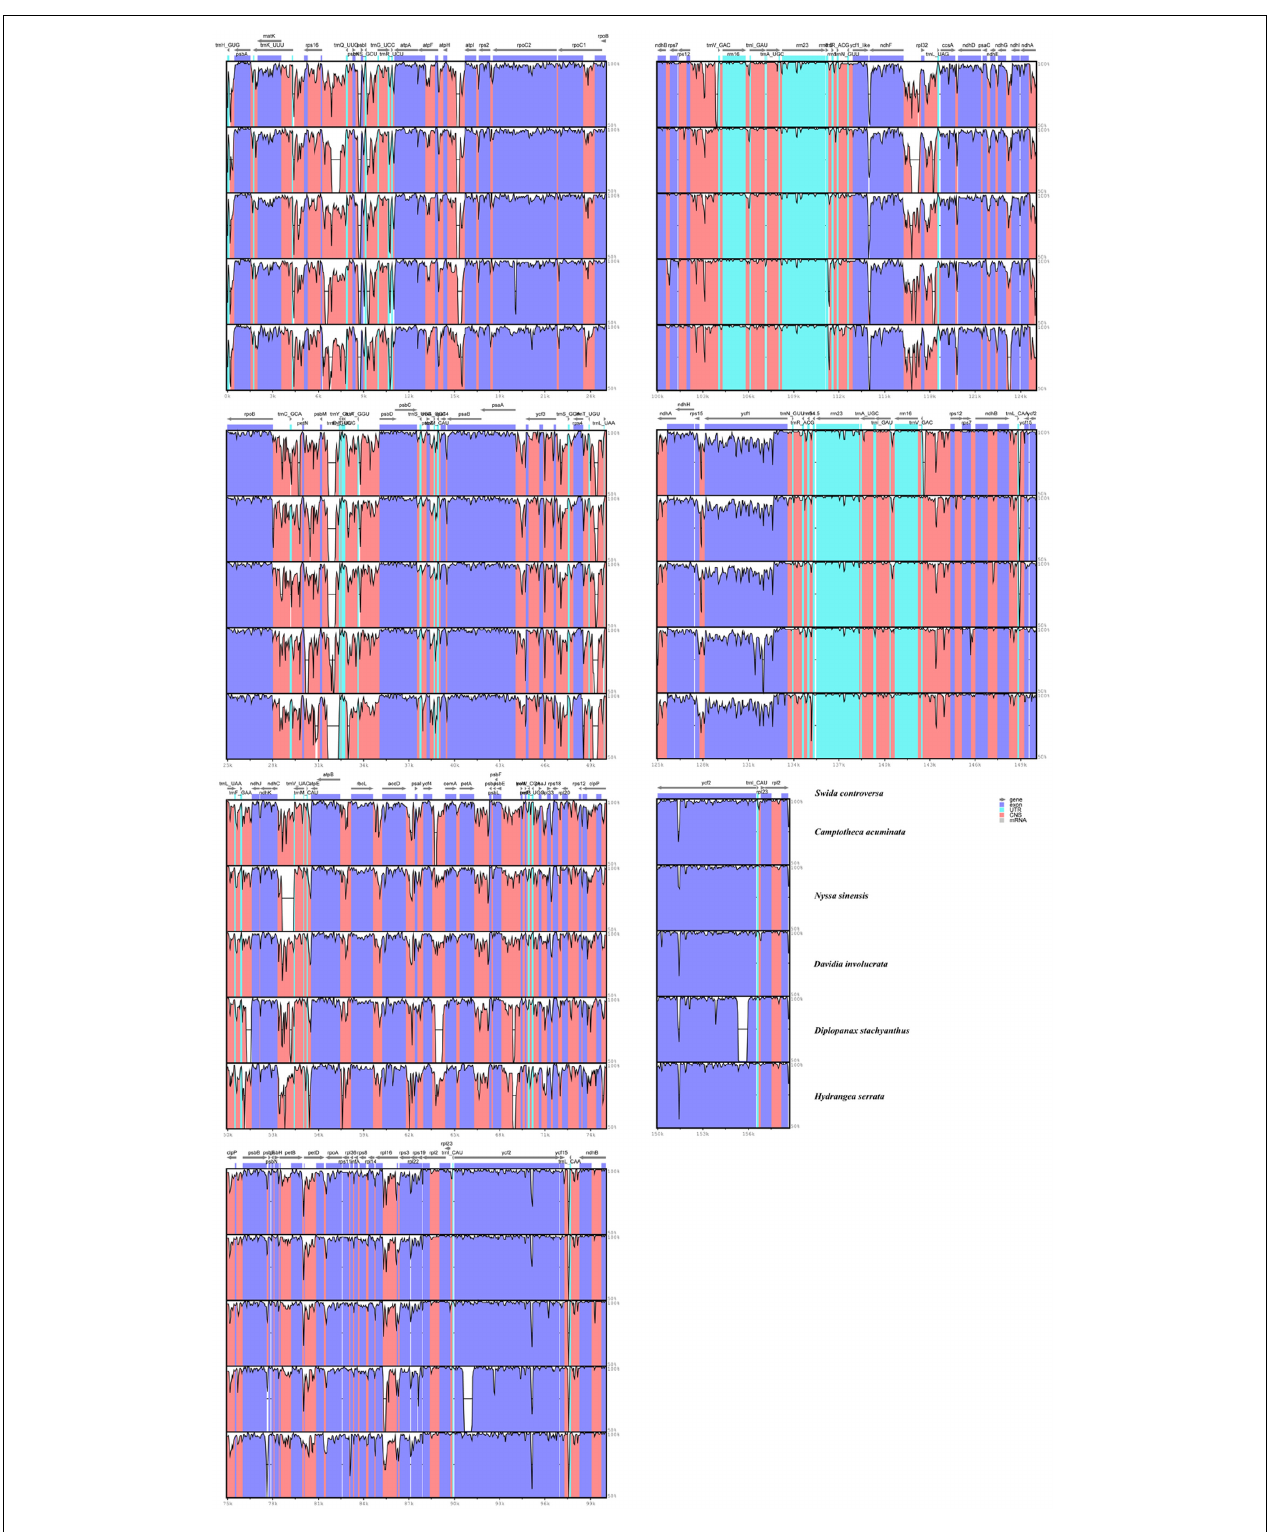
FIGURE 3 | Visualized alignment of the six Cornales chloroplast genomes. The mVISTA-based identity plots show the sequence identity among the six cp genomes, with S. controversa serving as a reference. Gray arrows indicate the position and direction of each gene. Genome regions are color-coded as protein-coding, r RNA, t RNA, or conserved non-coding regions. Black lines define the regions of sequence identity shared with S. controversa (by using a 50%-identity cutoff).